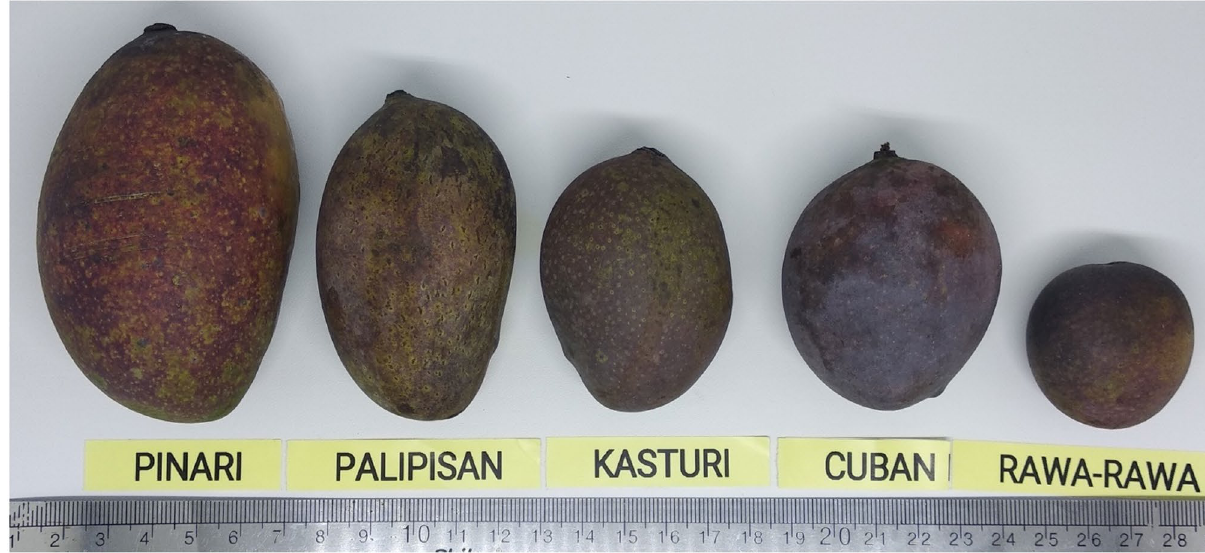
Figure 1. Appearance Fruits of M. casturi hybrids (from left to right: Pinari, Pelipisan, Kasturi, and Cuban) and closely related species (Rawa-rawa). This photo was taken by